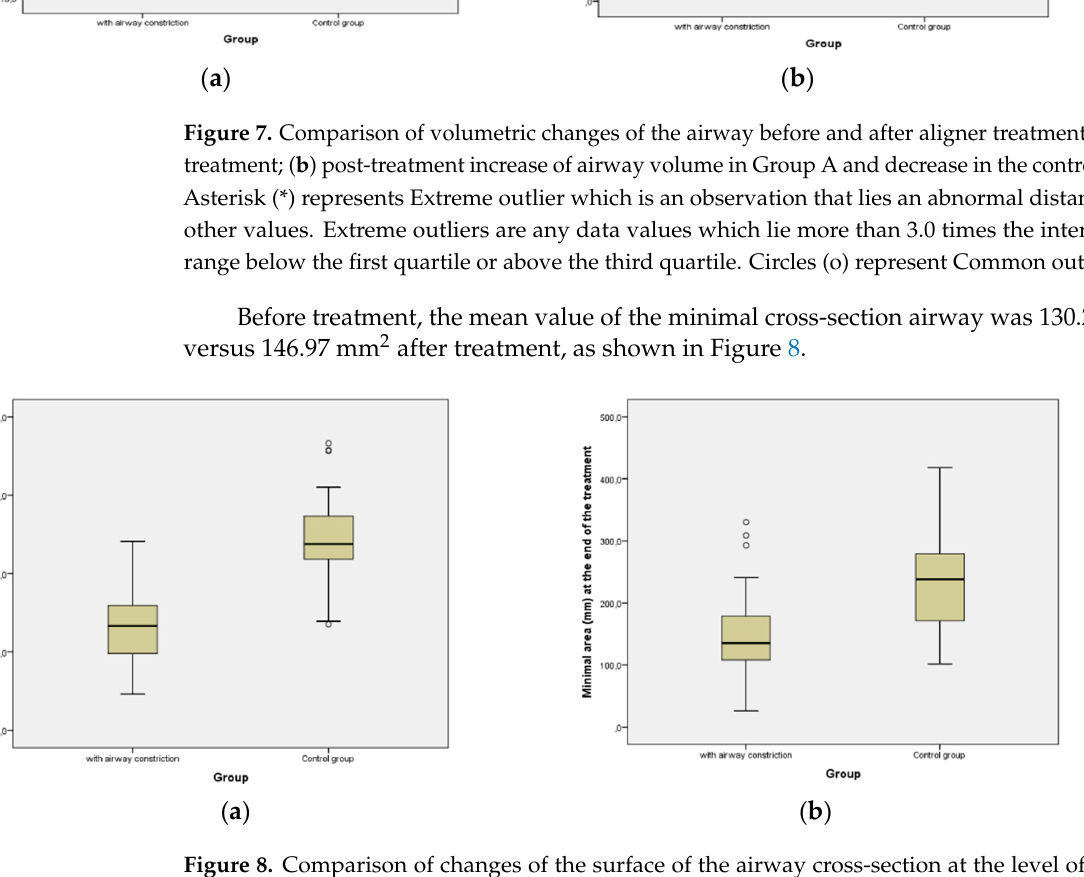
Figure 8. Comparison of changes of the surface of the airway cross-section at the level of highest constriction. ( a ) At the beginning of aligner treatment; ( b ) Post-treatment. The surface of the most constricted cross-section of airway did not change significantly after treatment in any of the groups.